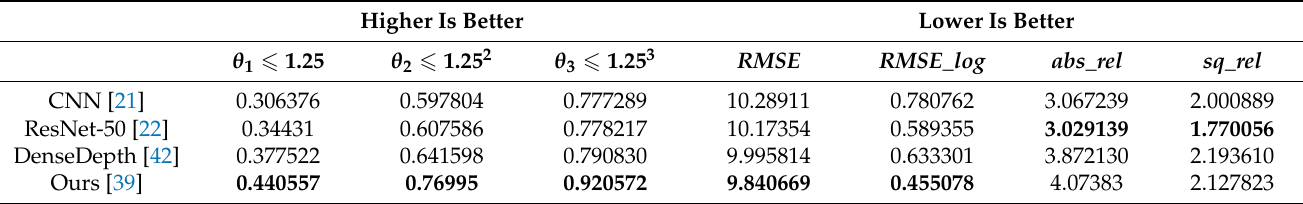
Table 2. Results of the comparison experiment on the relief dataset. Higher Is Better Lower Is Better θ 1 (cid:54)